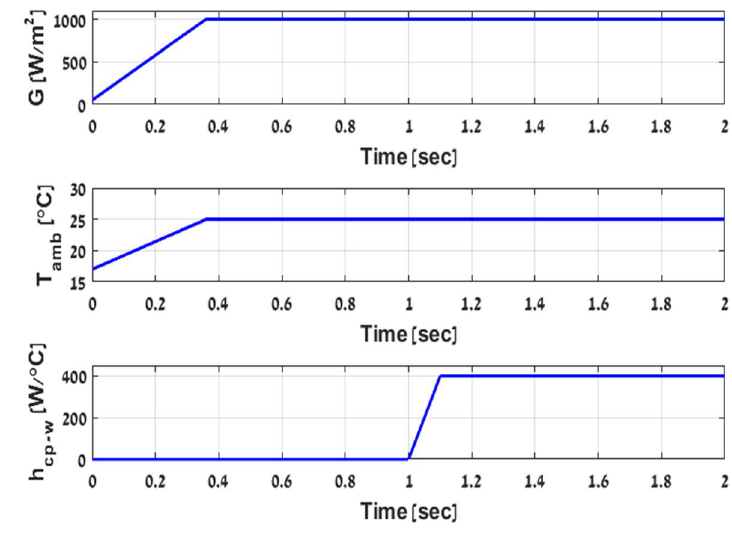
Figure 6. Illustration of simulation input parameters.